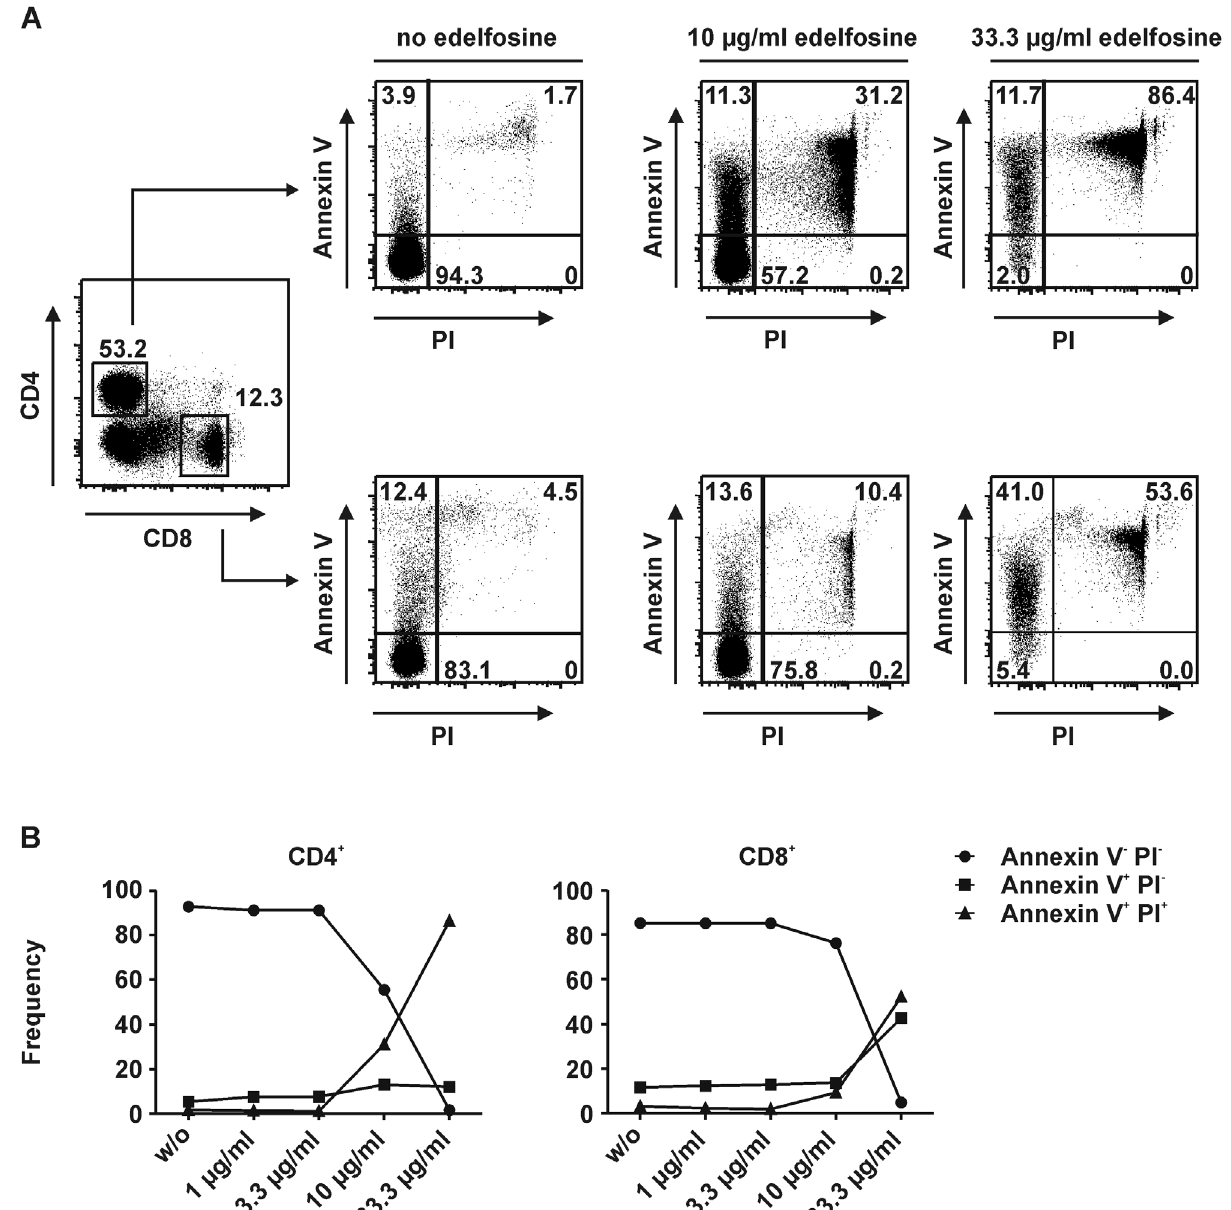
Figure 1. Edelfosine impact on T cell viability. (A) Gating strategy to determine frequencies of annexin V + and/or PI + CD4 + as well as CD8 + T cells. Dot plots for annexin V and PI gating of approaches in absence of edelfosine, with 10 m g/ml edelfosine, or 33.3 m g/ml edelfosine. (B) With regard to CD4 + T cells just 10 m g/ml edelfosine led to a decrease in annexin V 2 PI 2 frequencies accompanied by a remarkable increase in annexin V + PI + CD4 + T cell frequencies. In the case of CD8 + T cells a marked decrease in annexin V 2 PI 2 cells was only observed with 33.3 m g/ml edelfosine which resulted in comparable frequencies of annexin V + PI 2 as well as annexin V + PI + cells. PBMCs of a donor were seeded in triplicates and pooled before